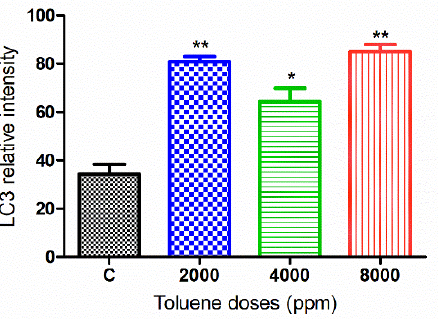
4000 ppm-treated group ( G – I ) and 8000 ppm-treated group ( J – L ). Scale bars = 100µm.